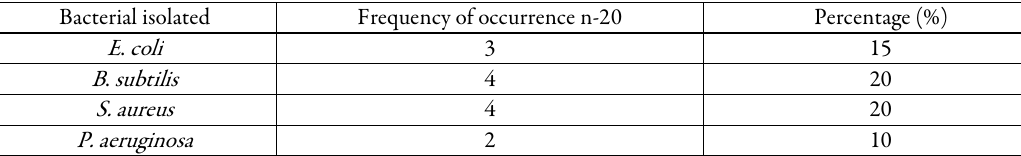
Table 7. Frequency occurrence of bacteria isolated from bread samples Bacterial isolated